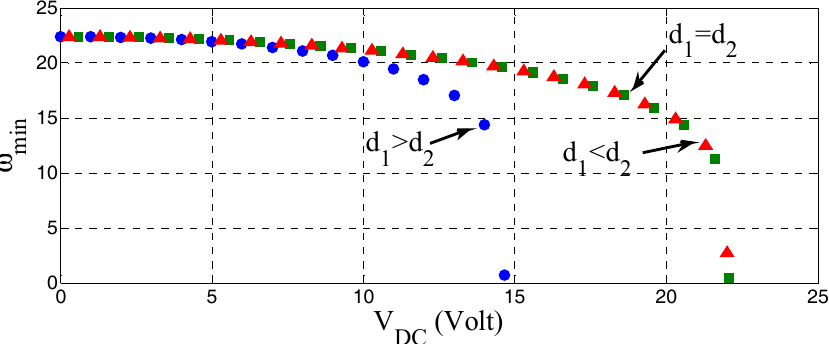
Figure 9. Variation of the fundamental natural frequencies with the applied DC voltage for the case of the double-microbeams based actuator and for three different cases of the microbeams initial air gaps.